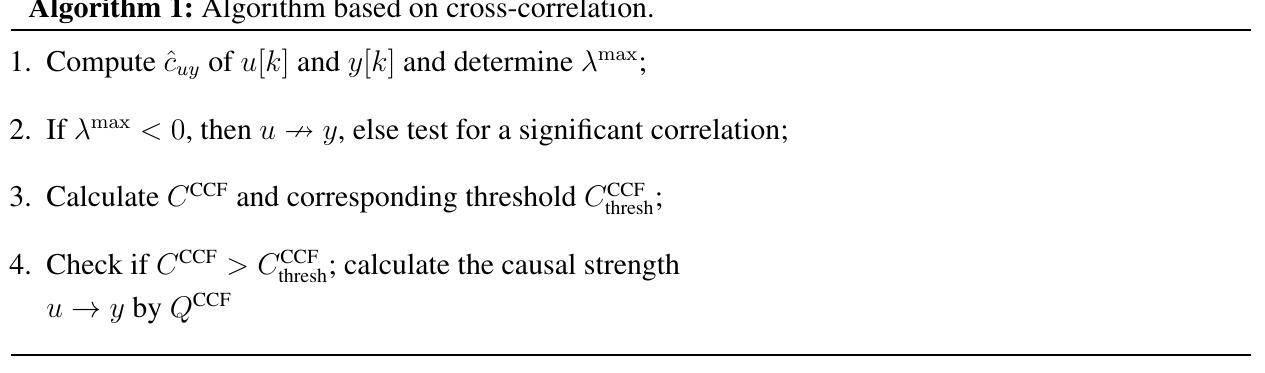
Algorithm 1: Algorithm based on